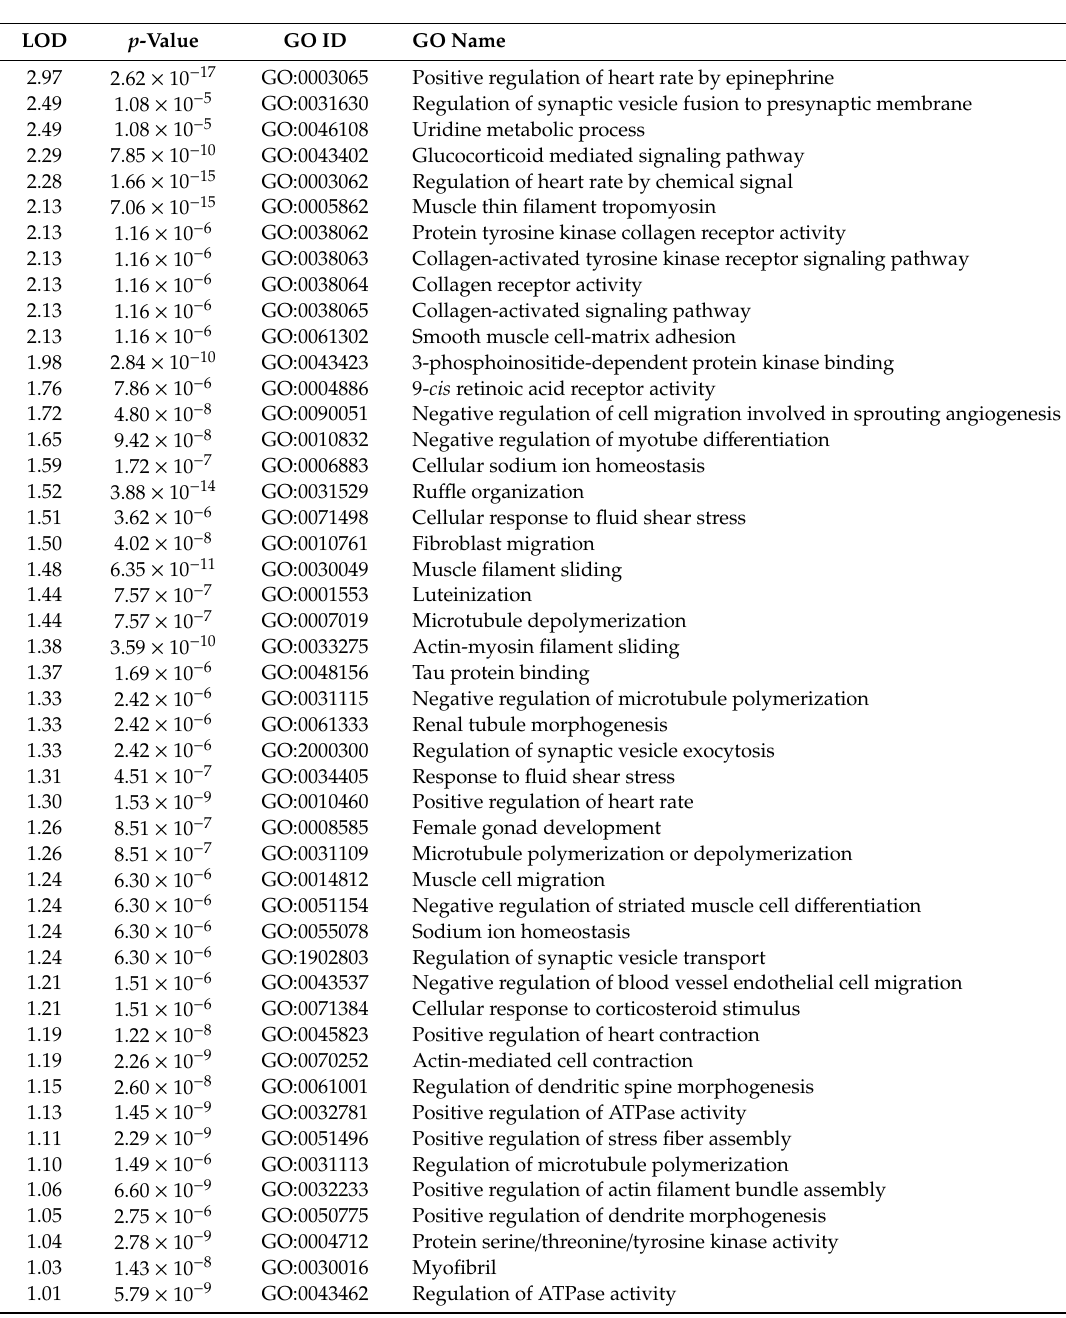
Gene function annotation list of down-regulated gene sets in Colon-26MGS, but not in